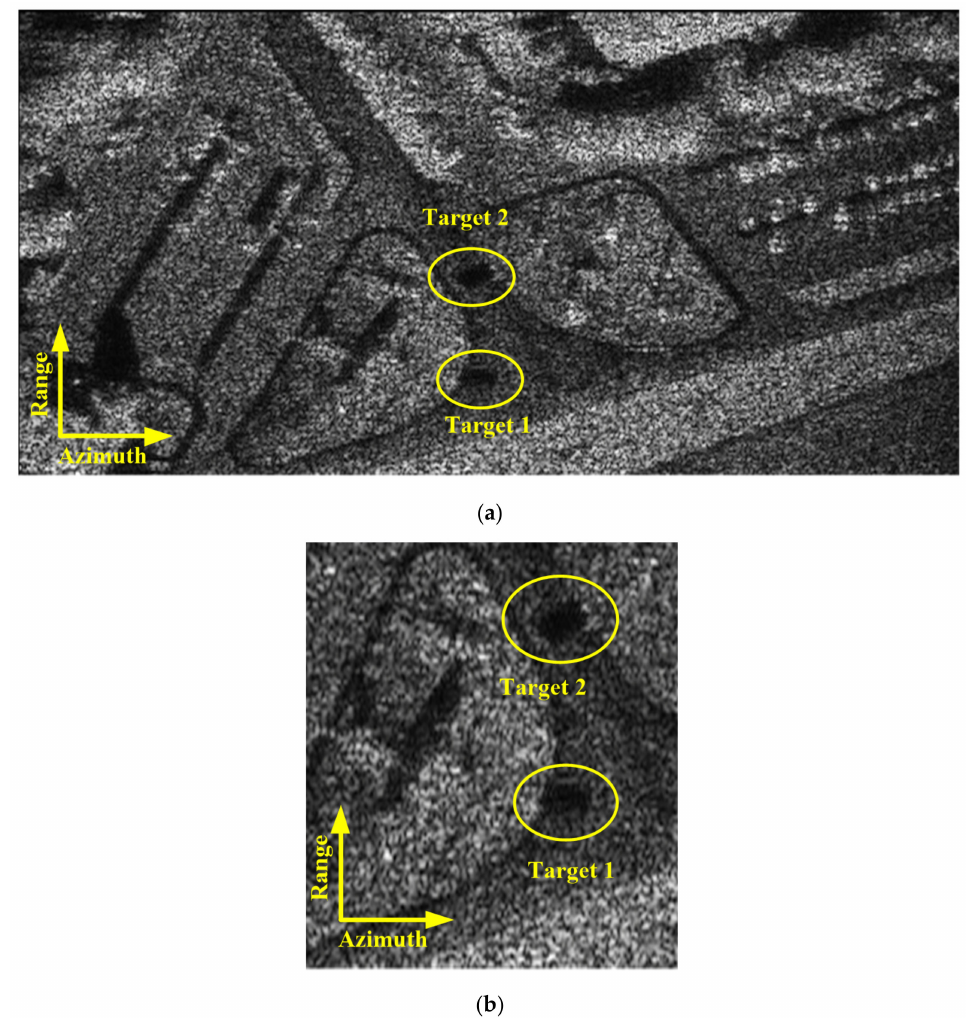
Figure 22. ( a ) Simulated natural scene reconstructed by Ka-band while the receiver is mixed with thermo-noise. ( b ) Localized result with moving